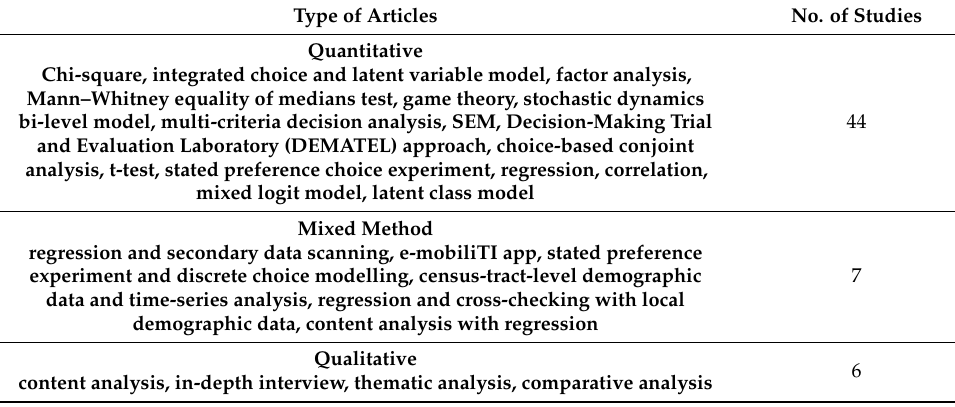
Table 4. Methods used in consumer adoption of EVs research.